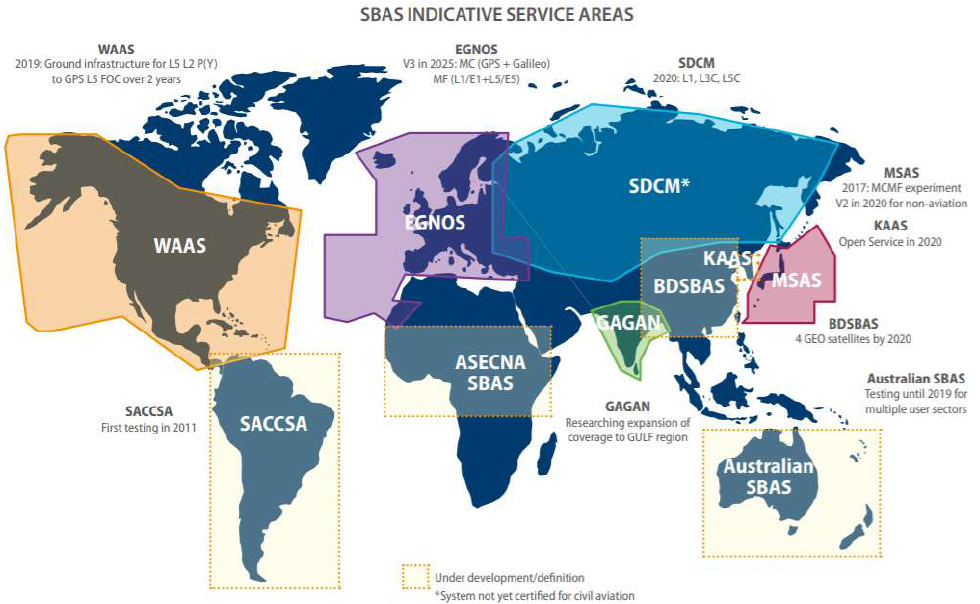
Figure 2. Existing and future Satellite-Based Augmentation Systems (SBASs) around the world. (Reproduced from [5], with permission from GSA, 2018).